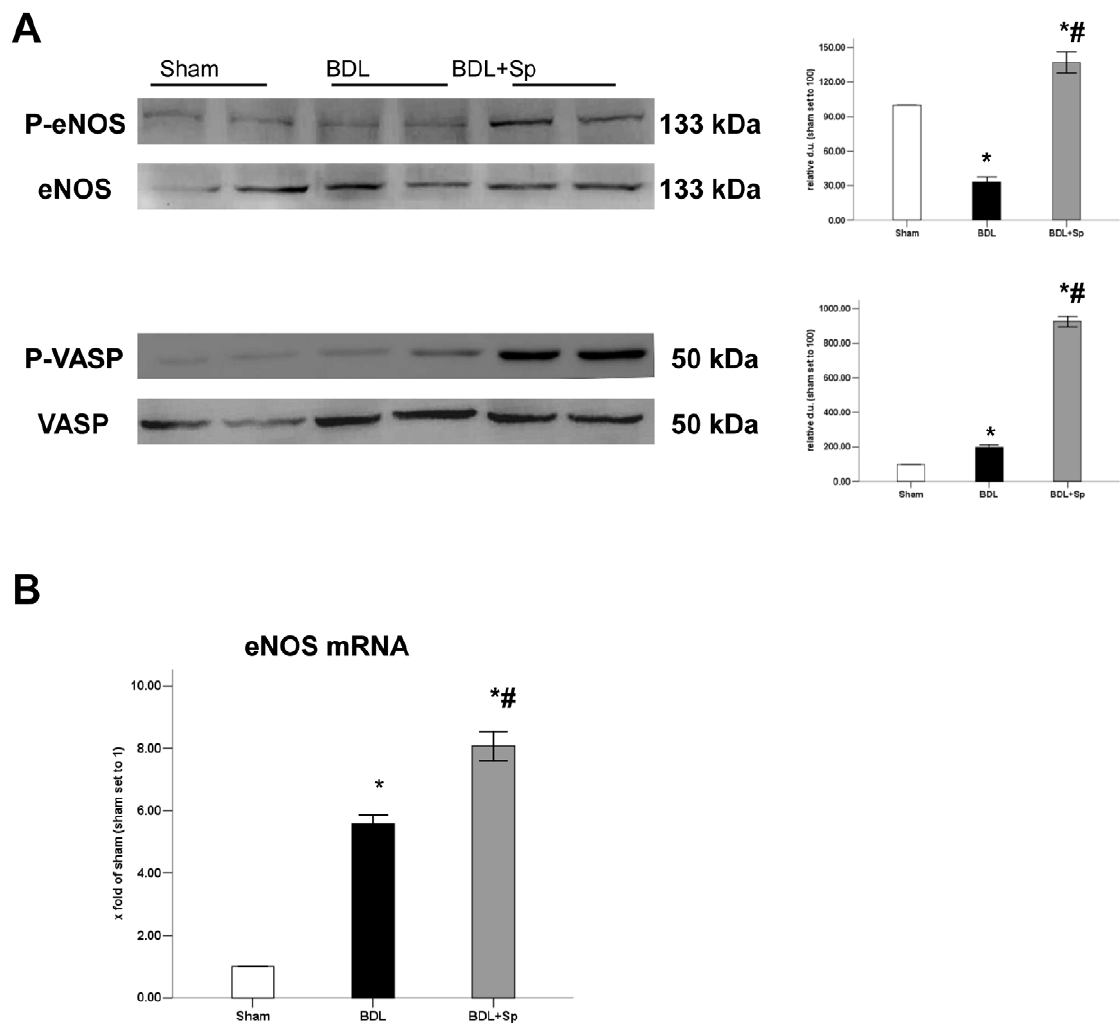
Figure 6. Sprionolactone (Sp) increased the phosphorylation of vasp in BDL- treated rats. (A) Western blot analysis of the total- or phospho-vasp and eNOS in BDL rats. The expression levels of phospho-vasp and eNOS are measured relative to the total-vasp and eNOS respectively. (B) Real-time PCR analysis for eNOS mRNA expression. * p , 0.05 compared to the Sham group. # p , 0.05 compared to the BDL groups.